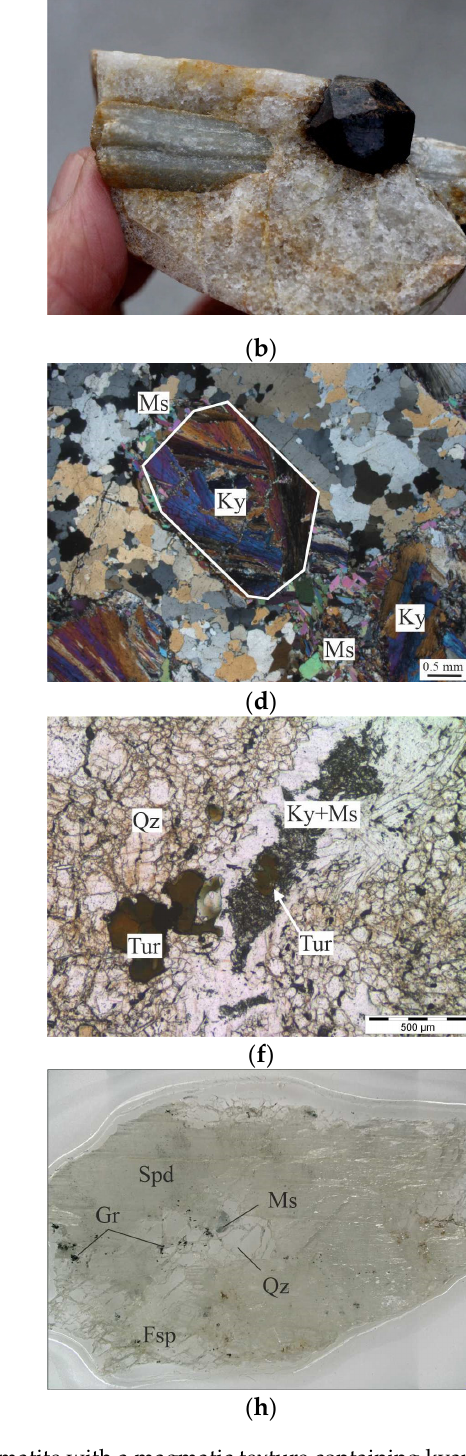
Figure 2. Pegmatite mineral assemblage. ( a ) Pegmatite with a magmatic texture containing kyanite paramorphs (blue) in a very fine-grained quartz matrix; tourmaline and garnet (bottom of image) occur accessorily. The length of the block is ca. 60 cm. ( b ) Hand specimen of fine-grained recrystallized quartz matrix surrounding a large kyanite paramorph crystal and a garnet. Thumb for scale. ( c ) A thick section of garnet porphyroblasts (Grt) embedded in a matrix consisting of muscovite (Ms), kyanite (Ky), and quartz (Qz). Garnet shows intense cracking. Light and dark areas in garnet contain fluid and solid inclusions. Muscovite aggregates close to garnet grain boundaries are shown inside the ellipse. ( d ) Kyanite and muscovite replace andalusite (kyanite paramorphs after andalusite), best visible in the former shape of andalusite (white frame) (thin section). ( e ) Tourmaline poikiloblast (Tur) containing quartz inclusions with a high amount of FIs (white arrows). ( f ) Tourmaline enclosed in quartz matrix but also surrounded by fine-grained kyanite + muscovite and quartz aggregates. Kyanite + muscovite are considered to replace a former andalusite crystal that formed in equilibrium with